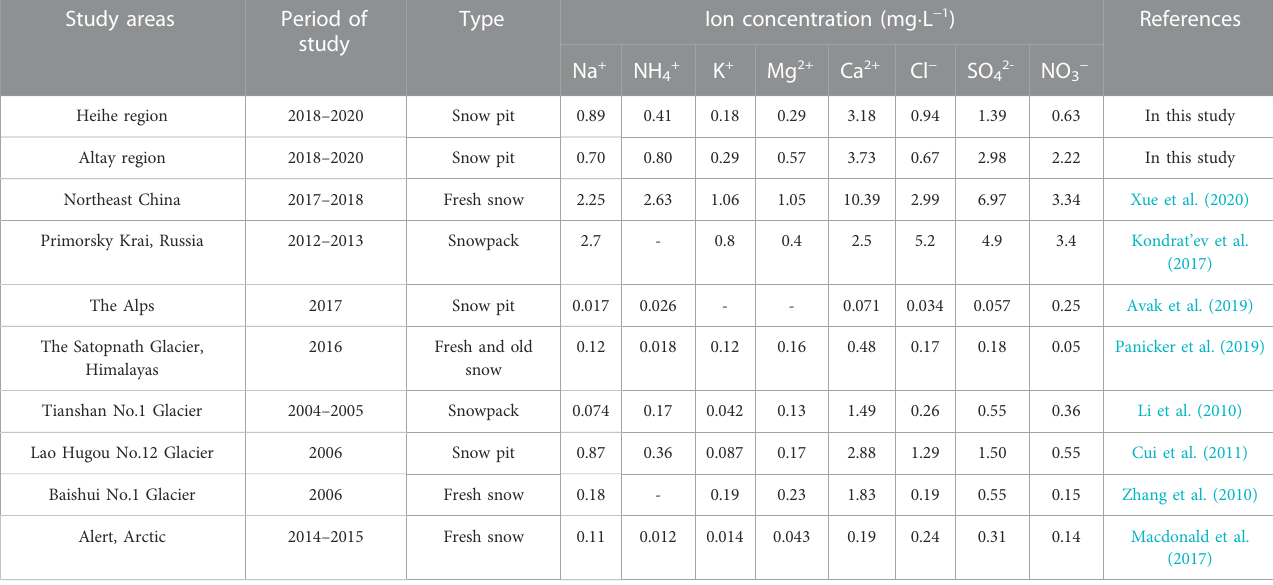
TABLE 3 Comparison of ion concentration between the study area and other typical snow cover areas. Study